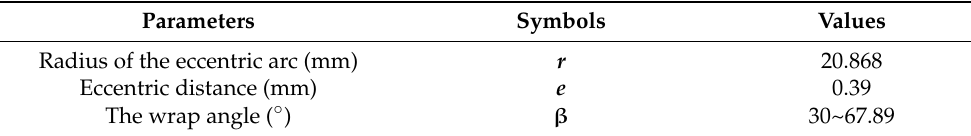
Table 2. The parameters of the wave generator.